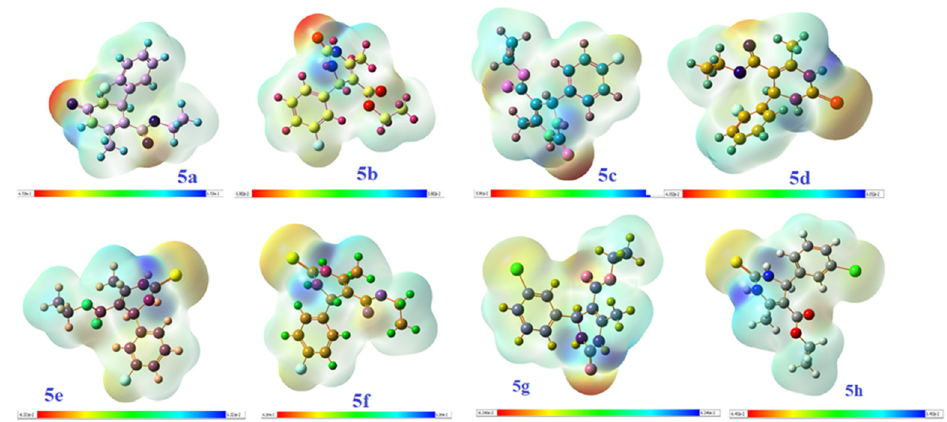
Figure 15. MEP of the compounds 5a – h based on SCF